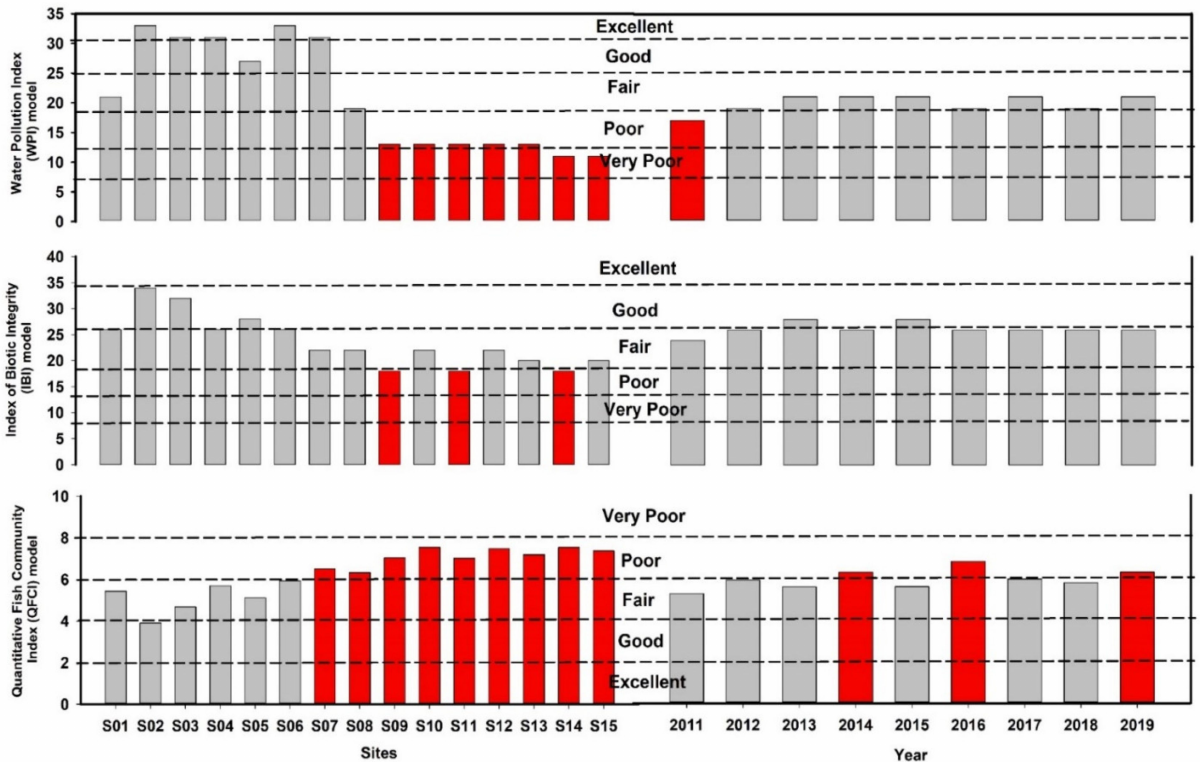
Figure 5. Chemical and biological health status of the Geum River basin based on sites and year (red bars indicate “poor” and “very poor”